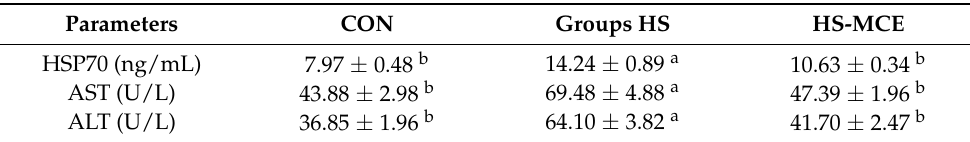
Table 1. Serum levels of HSP70, ALT, and AST.